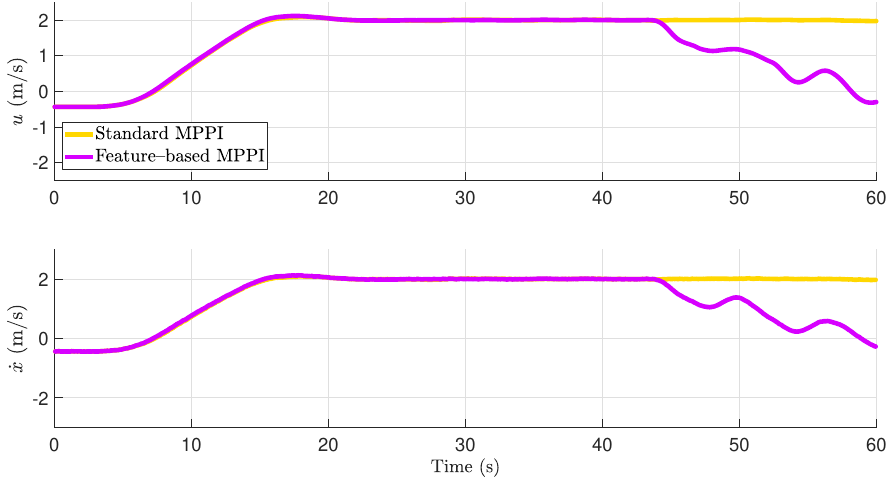
after the vessel appears. This effect results from the fact that, due to the small explored state-space using conventional MPPI control, all predicted trajectories cause a collision for t > 44 s.